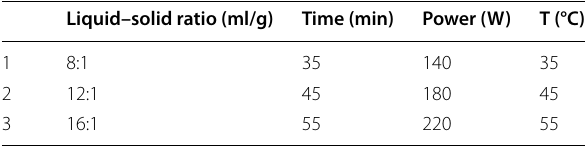
Table 1 Factors and levels of orthogonal test of ultrasonic